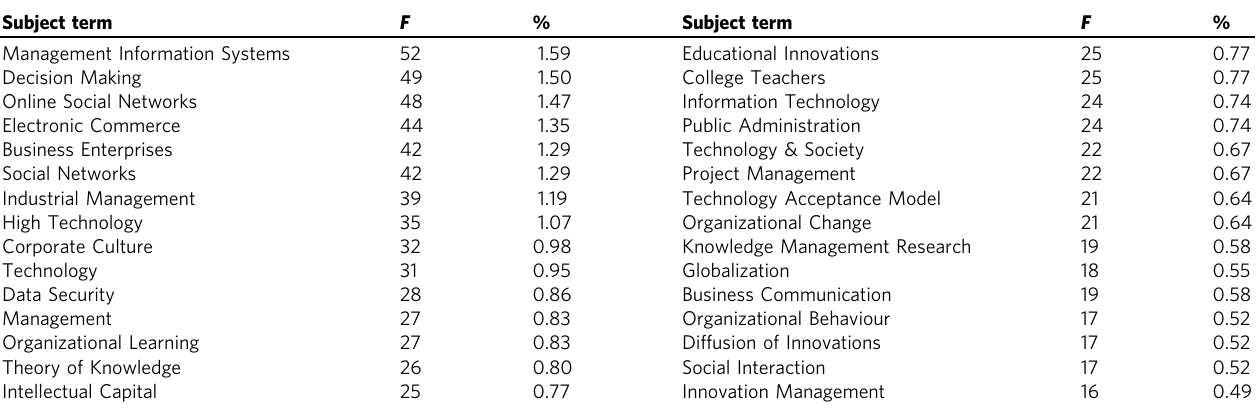
Table 4 Core subject terms in ICT research, 2008 – 2012 ( N = 3265).